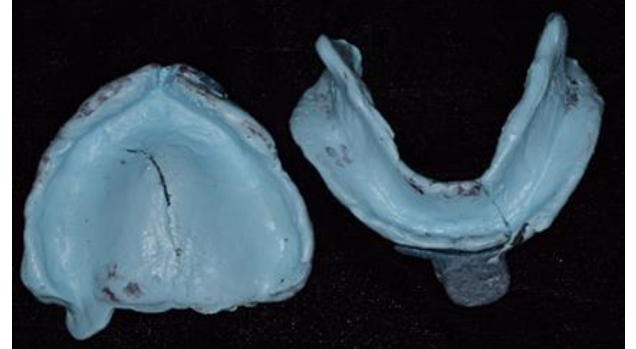
Fig. 5B. Final denture of the upper jaw(intaglio surface).